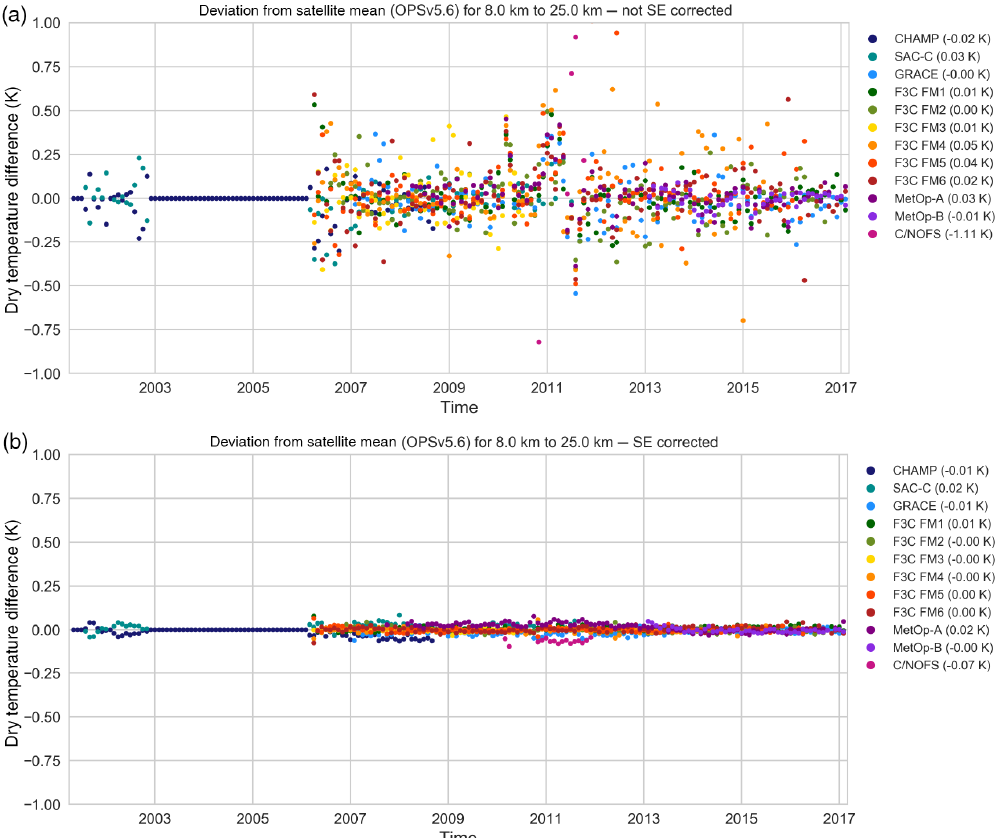
Figure 9. Deviations of individual satellites from the multi-satellite mean for monthly mean dry temperature in altitude layer 8–25km, without sampling error (SE) correction (a) and with SE correction applied (b) . The satellite mean is calculated from all missions available for the respective month (note that before May 2006 only CHAMP and SAC-C delivered